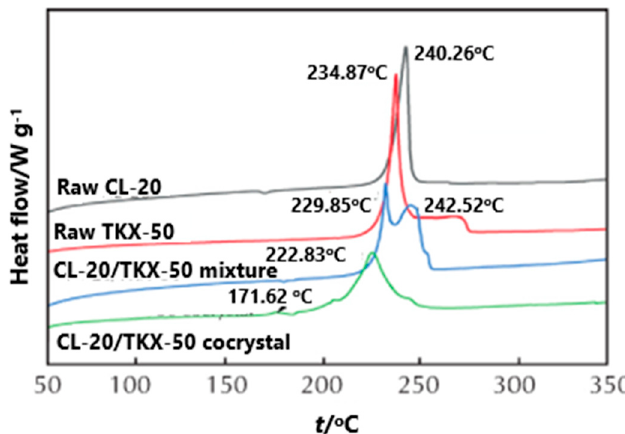
Figure 16. DSC curves of CL-20, TKX-50, CL-20 / TKX-50 mixture and CL-20 / TKX-50 cocrystal [34], with permission from Huo Zha Yao Xue Bao, 2020.